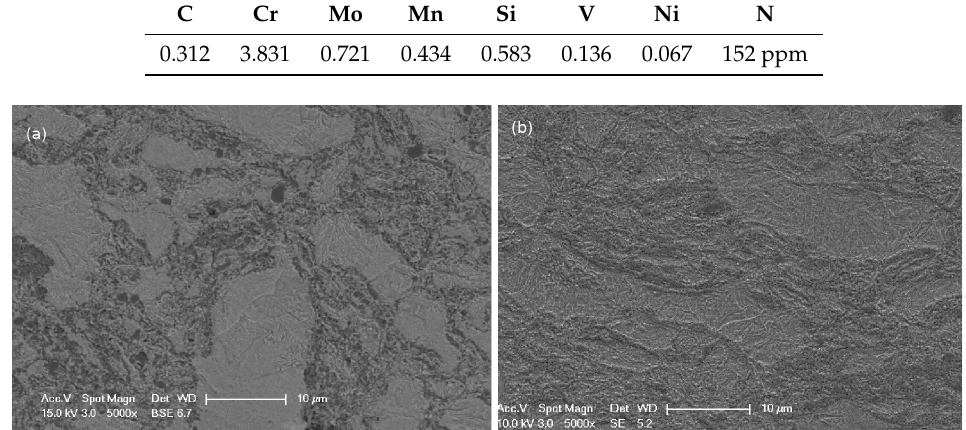
Figure 1. Metal matrix composite (MMC) microstructure ( a ) at initial state and ( b ) after the thermal treatment.